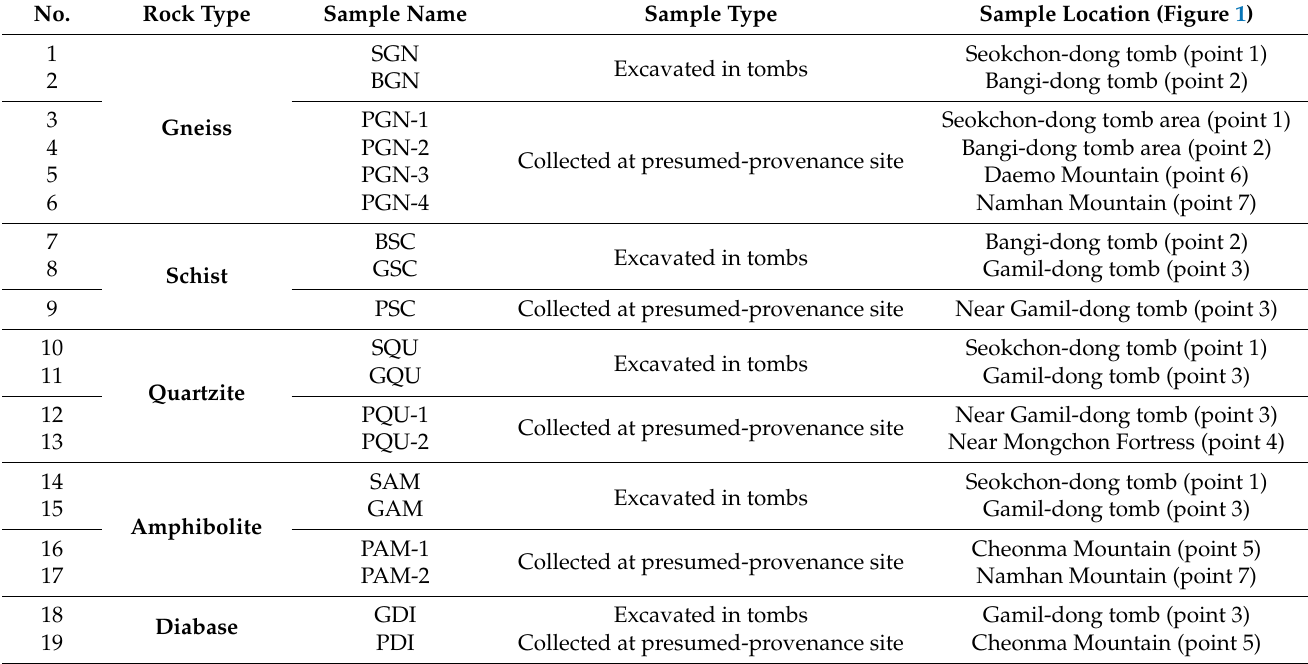
Table 1. Sample list by rock